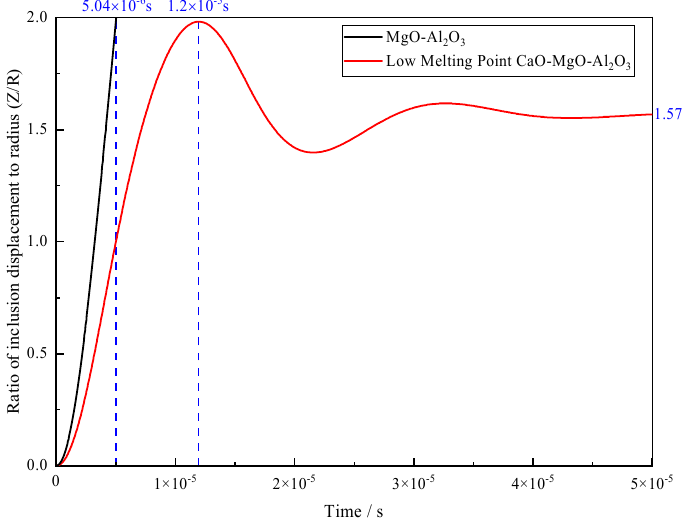
Table 3. Calculated values of inclusion radius, interfacial tension, density, and viscosity.